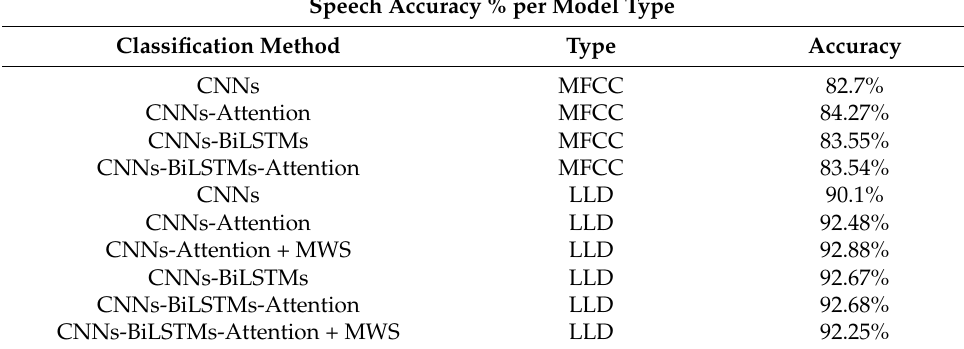
Table 2. Accuracy (Speech Processing)